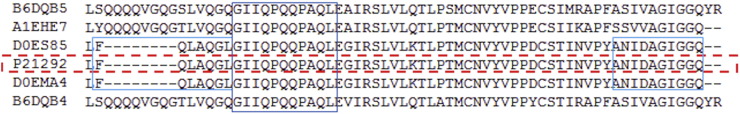
Partial sequence alignment of multiple gamma gliadins showing the occurrence of peptides deemed unique when Viridiplantae database was used to search MS data.Peptides (FQLAQGL, GIIQPQQPAQL and ANIDAGIGGQ, indicated by the blue solid-lined boxes) deemed unique to P21292 (highlighted in the red dashed-lined box), are present in multiple other gamma gliadins (Uniprot accessions: B6DQB5, A1EHE7, D0ES85, D0EMA4, B6DQB4).